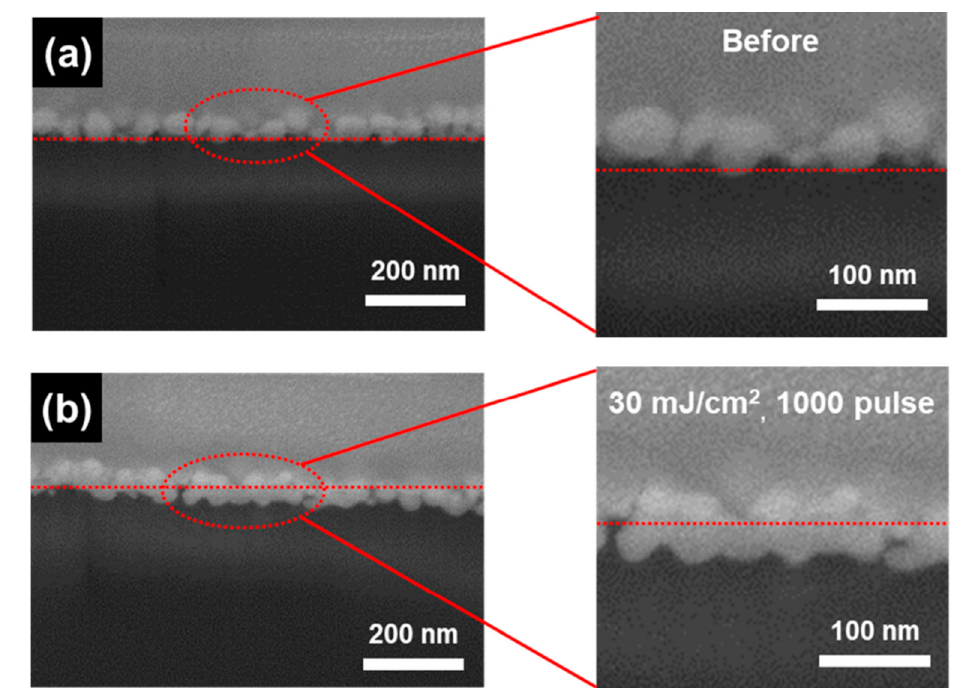
Figure 21. Cross-sectional SEM images ( a ) before fs laser sintering and ( b ) after fs laser sintering (F = 30 mJ/cm 2 , effective pulse number = 1000) (Adapted from reference